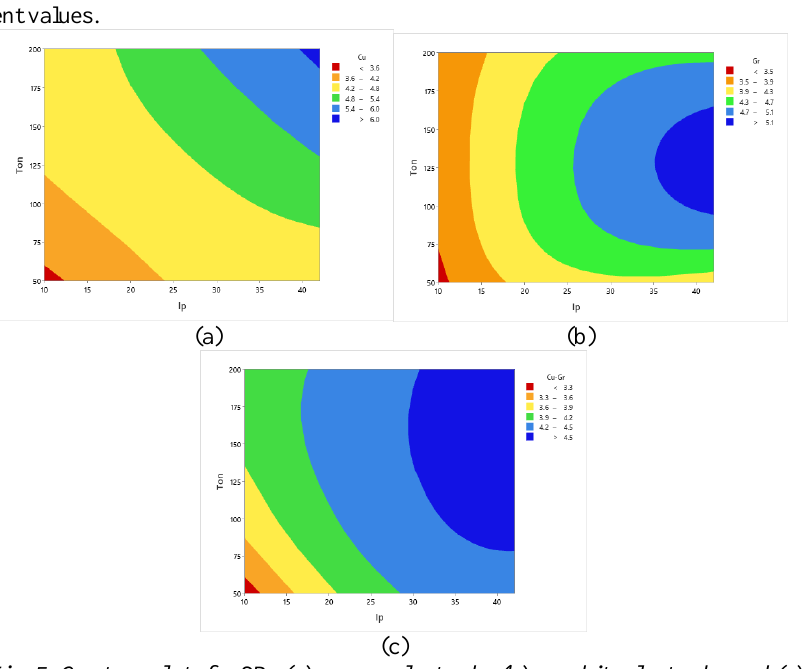
Fig. 5. Contour plots for SR; (a) copper electrode, (b) graphite electrode, and (c) copper-graphite